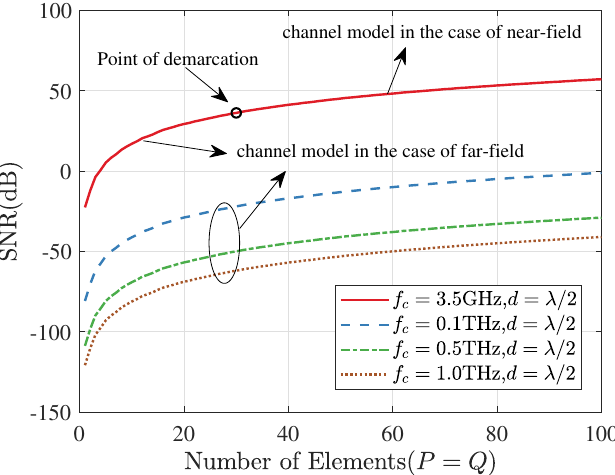
Figure 4. The influence of different operating frequency bands on the auxiliary link